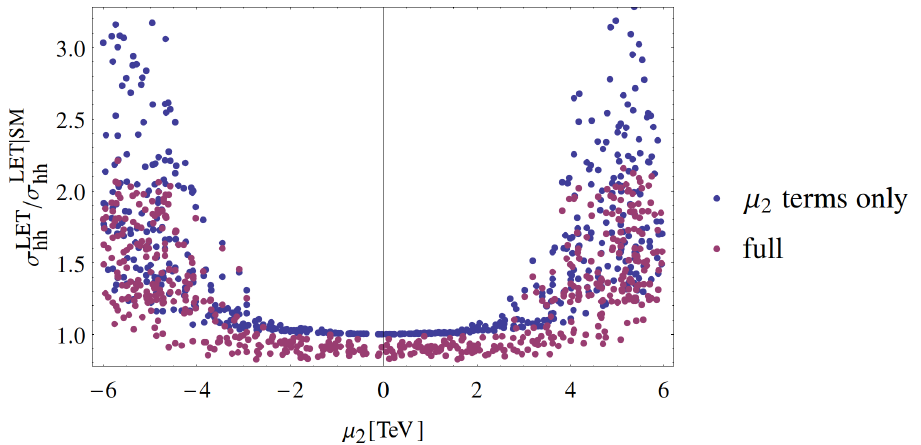
/σ LET | SM ) − 1 to LO as a function of m light hh hh